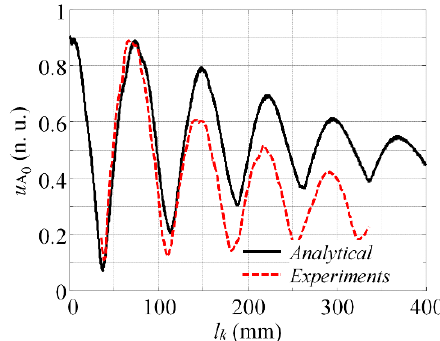
Figure 11. Magnitude variation of A 0 mode due to the size of defect at fixed depth: comparison between analytical calculations and experiment.